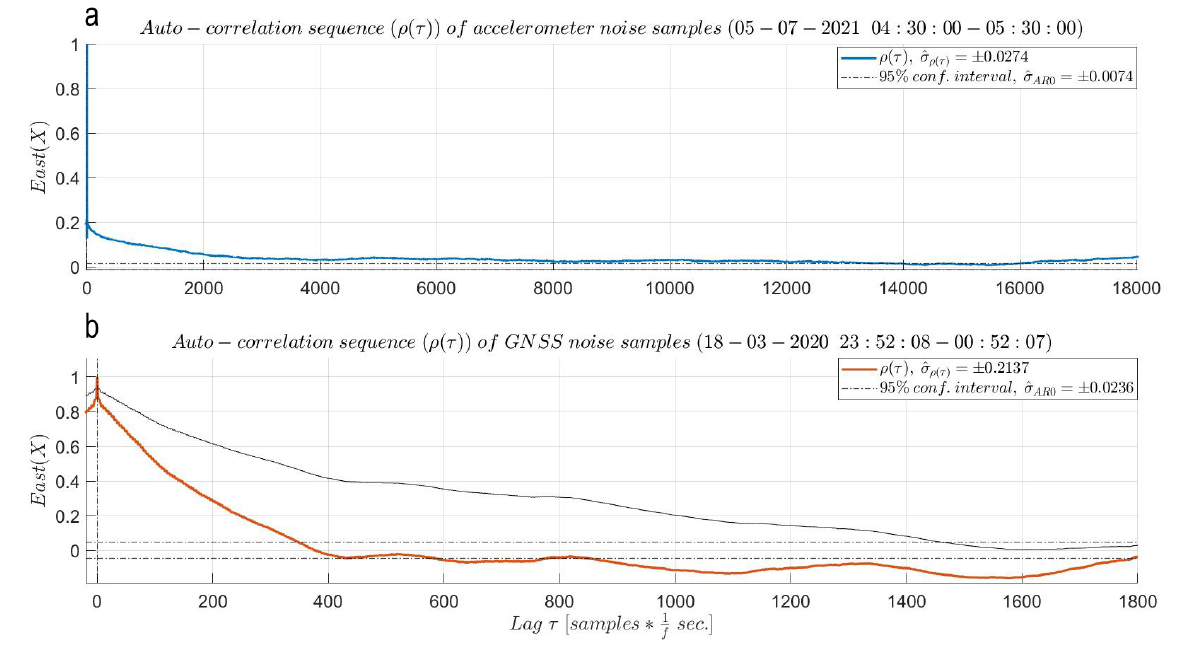
Figure 6. East (auto)correlation analysis: ( a ) Smartphone accelerometer—correlogram of random noise sequence converges close to the 95% confidence interval of an AR0 process, settling after 3078 samples and fluctuating close to its upper limit, corresponding to a correlation period of 62 s. The North and Up components show almost no time correlation, with correlation periods of 5 and 1 s, respectively. ( b ) GNSS system—red correlogram of random noise sequence enters into the 95% confidence interval of an AR0 process after approximately 349 samples followed by still some fluctuations. This corresponds to an (auto)correlation period of 69.8 s. The thin black correlogram is derived from the noise sequence (uncorrected for MP) resulting from the subtraction of the mean baseline value from the East baseline time series. The difference in time correlation between the two auto-correlation sequences attests to the reduction in MP on behalf of the LS polynomial subtraction. For the GNSS instrument, the North and Up components show similar behavior. Both (auto)correlation functions are plotted up to a lag at maximum equal to 1 of the length of the selected one hour 10